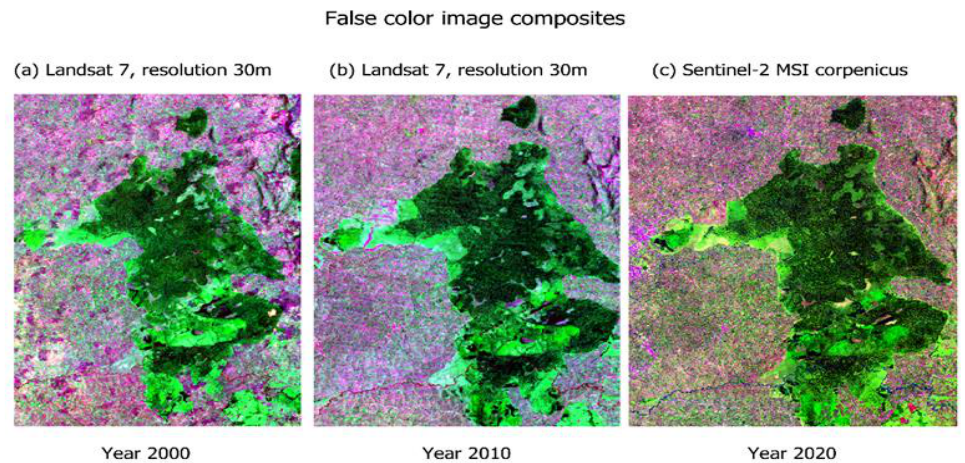
Figure 2. False colour image composites showing forest change at different timescales ( a ) 2000, ( b ) 2010 and ( c ) 2020 of Kakamega Forest National Reserve.